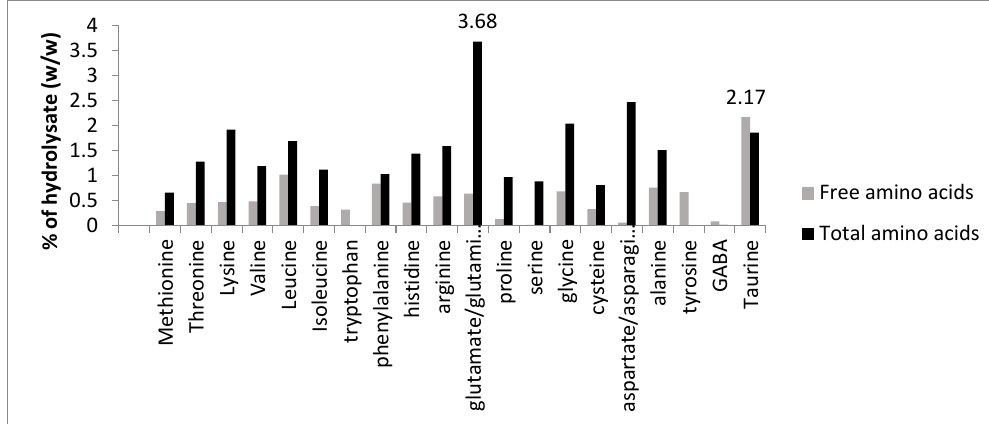
Figure 2. Free and total amino acid % composition ( w / w ) of mussel by-product Protamex ® hydrolysate for the Killary harbour November 2018 (KHN18) sample. The amino acids were quantified using a Jeol JLC-500/V amino acid analyser (Jeol Ltd., Garden city, Herts, UK) fitted with a Jeol Na+ high performance cation exchange column. Glutamate was the most abundant amino acid, whereas taurine was the most abundant free amino acid, as seen from the average values displayed on the two bars. Analysis was performed in triplicate (n = 1).